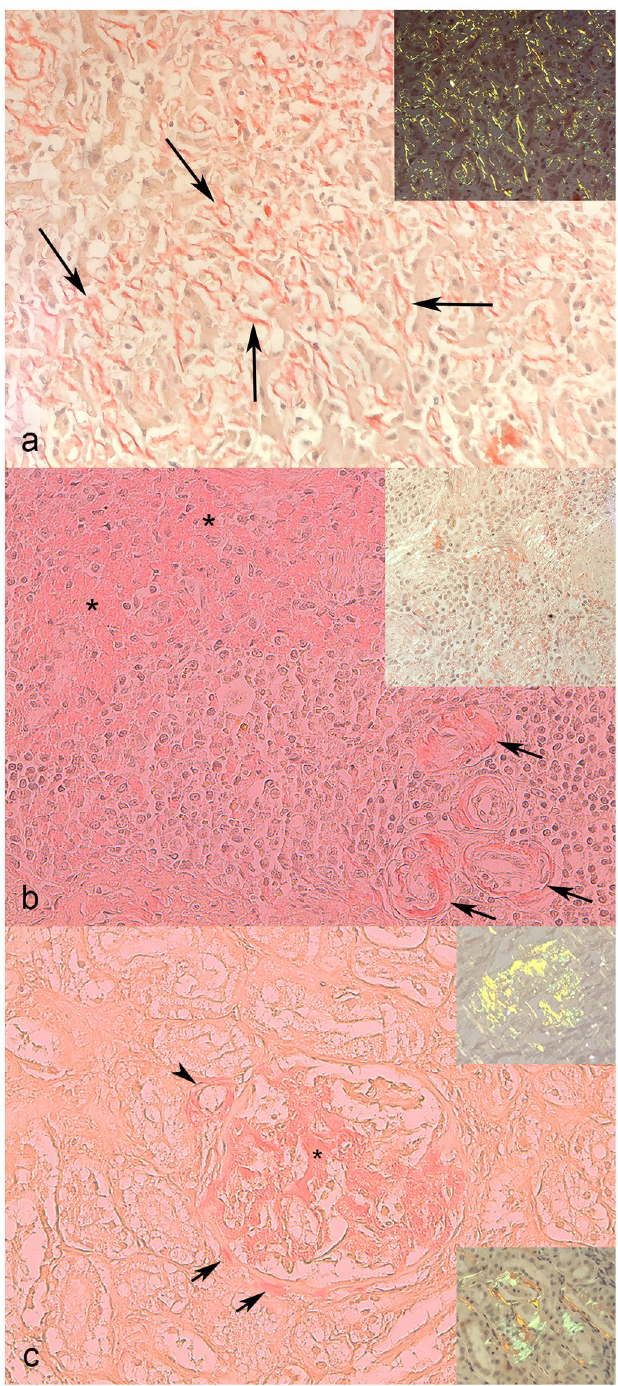
Fig 2. AA-amylodosis, cat. Congo red stain. a) Liver. A diffuse moderate amount of red stained amyloid (arrows) displaces the hepatocellular cords, sometimes isolating the hepatocytes. Inset: apple-green birefringence under polarized light. b) Spleen. Red stained amorphous material (amyloid, asterisks) is observed in the interstitium and around arteries (arrows). Inset: apple-green birefringence under polarized light. c) Kidney. The glomerular tuft is expanded by a large amount of Congo red-stained amorphous material (asterisk) consistent with amyloid, which is also present around a proximal arteriole (arrowhead) and along the Bowman’s capsule (arrows). Insets: Apple-green birefringence under polarized light is evident in a glomerulus (upper inset) and around tubules (lower inset). Histologic pictures of AA-amyloidosis-negative liver, spleen, and kidney is reported in S3 Fig.